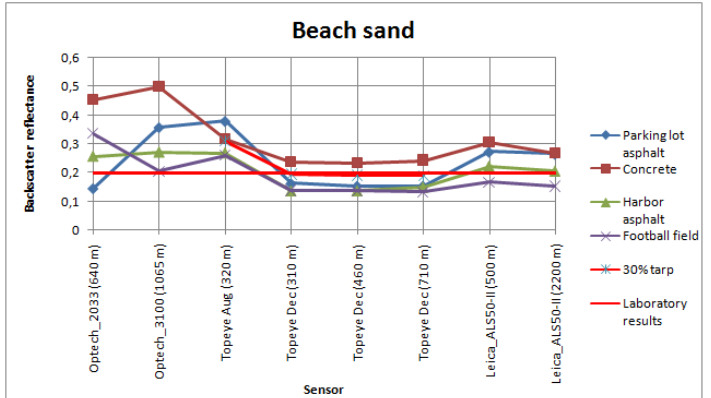
Figure. 7C. Backscatter reflectances of the beach sand sample calibrated with different samples as